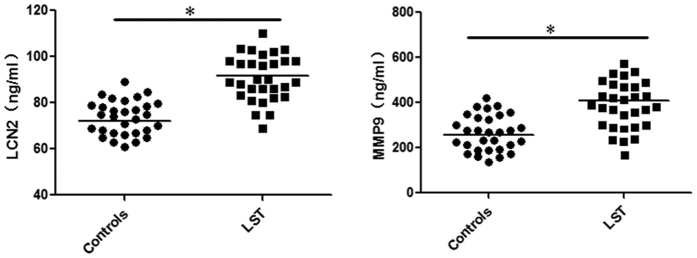
Protein expression of serum LCN-2 and MMP-9 detected by ELISA in the different clinical groups.Increased LCN-2 and MMP-9 serum levels were observed for all LSTs patients compared to healthy controls (P < 0.05).